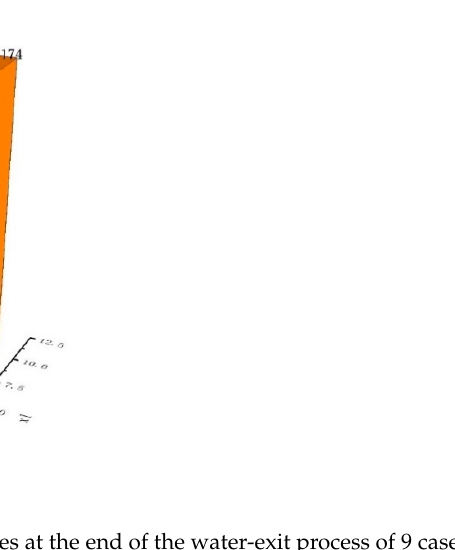
( c ) Figure 19. Images of pitch angle variation of vehicles under di ff erent initial velocities. ( a ) Pitch angle of vehicle in case 1, 4, 7. ( b ) Pitch angle of vehicle in case 2, 5, 8. ( c ) Pitch angle of vehicle in case 3, 6, 9. ( a ) 0 s ( c ) 0.66 s ( d ) 1 s Figure 20. Streamline diagram of vehicles fl ying out of water in case 2.